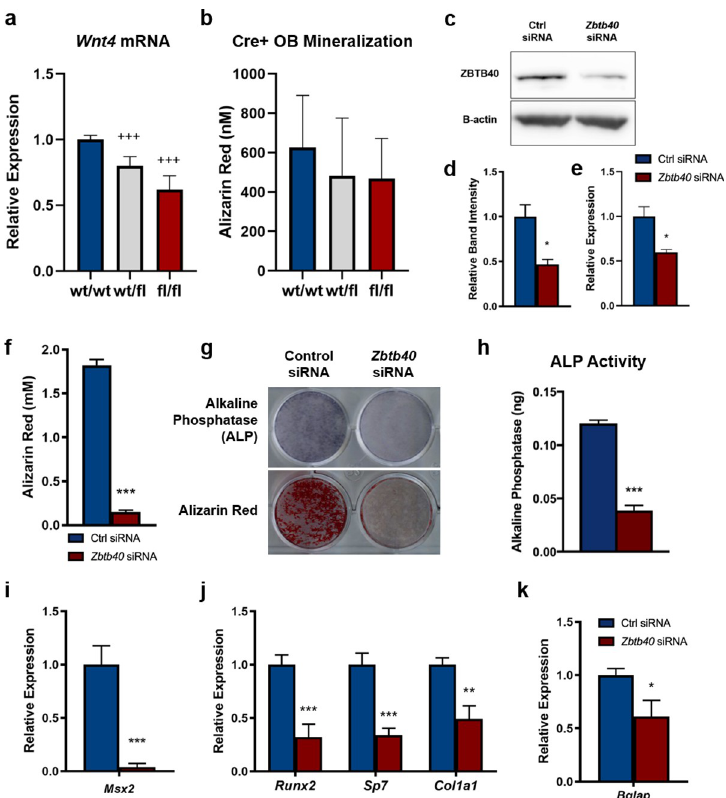
Fig 4. Knockdown of Zbtb40, but not Wnt4, inhibits osteoblast differentiation and mineralization. (A) Relative expression of Wnt4 mRNA levels in calvarial osteoblasts from differing genotypes isolated and transfected with a cre- expressing plasmid in vitro . (B) Quantification of Alizarin Red-stained cultures of Wnt4 knockdown (wt/wt n = 12, wt/ fl n = 45, fl/fl n = 21). (C) Immunoblot image and (D) quantification of ZBTB40 normalized protein levels in MC3T3 preosteoblast cells indicating knockdown. (E) Relative expression of Zbtb40 mRNA levels measured by qRT-PCR. (F) Quantification of Alizarin Red-stained Control (Ctrl) or Zbtb40 siRNA cultures. (G) Cell monolayer images of siRNA- treated cultures stained for Alkaline Phosphatase (ALP) or Alizarin Red measured at day 4 and day 21, respectively. (H) Quantified ALP per well measured by colorimetric activity assay. (I) Relative Expression of mRNA levels of Msx2 at day 0. Relative mRNA levels of early (J) and late (K) osteogenic factors measured at day 4 and day 21, respectively. n = 3 independently performed experiments. +++ = p < 0 . 0001 –One-way ANOVA with Dunnett’s , � = p < 0 . 05 �� = p < 0 . 01 ��� = p < 0 . 001 –Unpaired T test